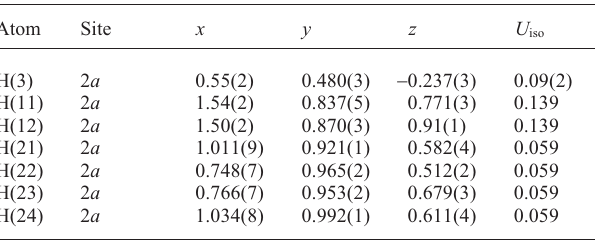
Table 2. Atomic coordinates and displacement parameters (in Å 2 ) .